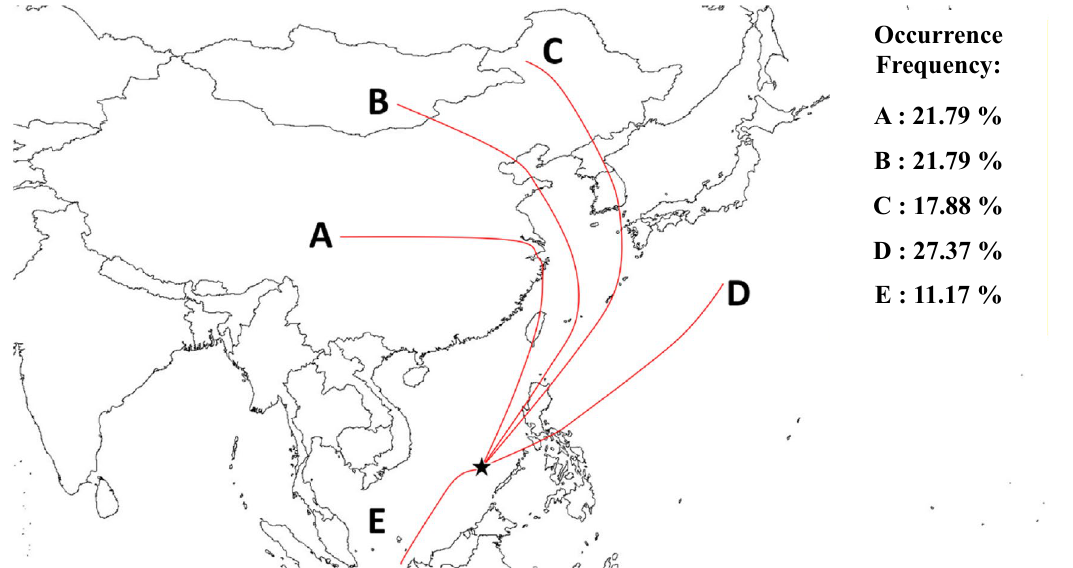
Figure 7. Clustered transport routes of air masses moving toward the Taiping Island in the South China Sea ( : Taiping Island). ★ Transport